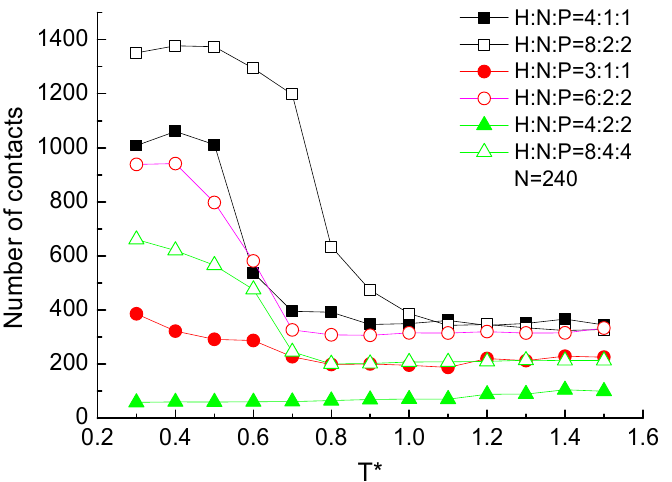
Figure 11. The number of contacts versus reduced temperature T ∗ of different ratio and serial number of H, N, and P residues with protein chain length N = 240 .